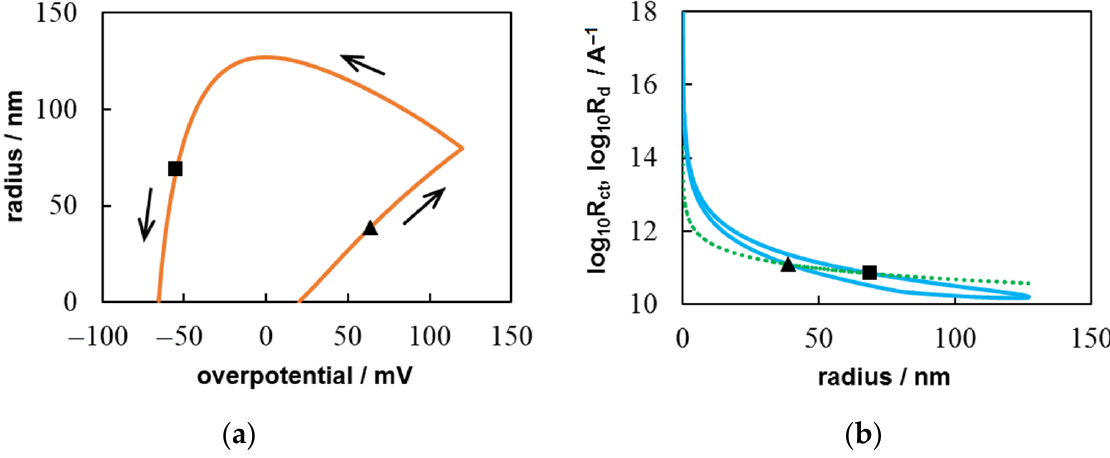
Figure 5. Calculated dependences of ( a ) the nucleus radius against overpotential and ( b ) the decimal logarithms of the contributions of the charge transfer ( R ct , solid line) and diffusion ( R d , dotted line) limitations against the nucleus radius. The symbols indicate the points, at which R ct = R d .